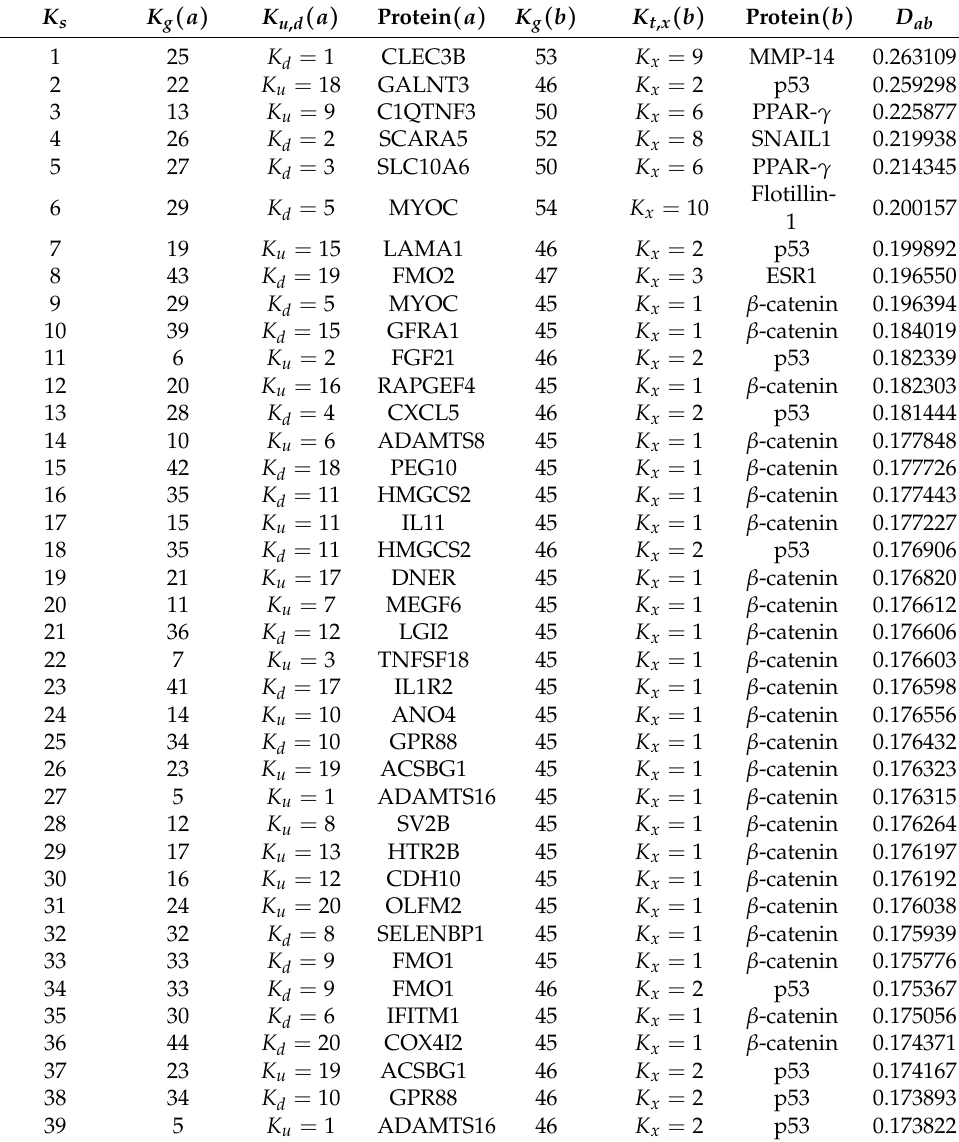
Table 2. List of 40 top protein pairs ( a , b ) with strongest sensitivity matrix element D ab , with a belonging to the subgroups of up- or down-proteins and b belonging to the subgroups of TGF- β and X-proteins. The first column gives the ranking index K s of D ab matrix elements ordered by a decreasing value, the second to fourth columns provide the K g , K u , d indexes and the name of the protein ( a ) , the fifth to seventh columns provide the K g , K t , x indexes and the name of the protein ( b ) , and the eighth column shows the value of D ab . See also Figure 5, which shows a color density plot for all matrix elements D ab , and Table 1 for the list of considered proteins. An ordered list of all 560 values of sensitivity influence values D ab of TGF- β or X-proteins (for “ b ”) on up-/down proteins (for “ a ”) is available at